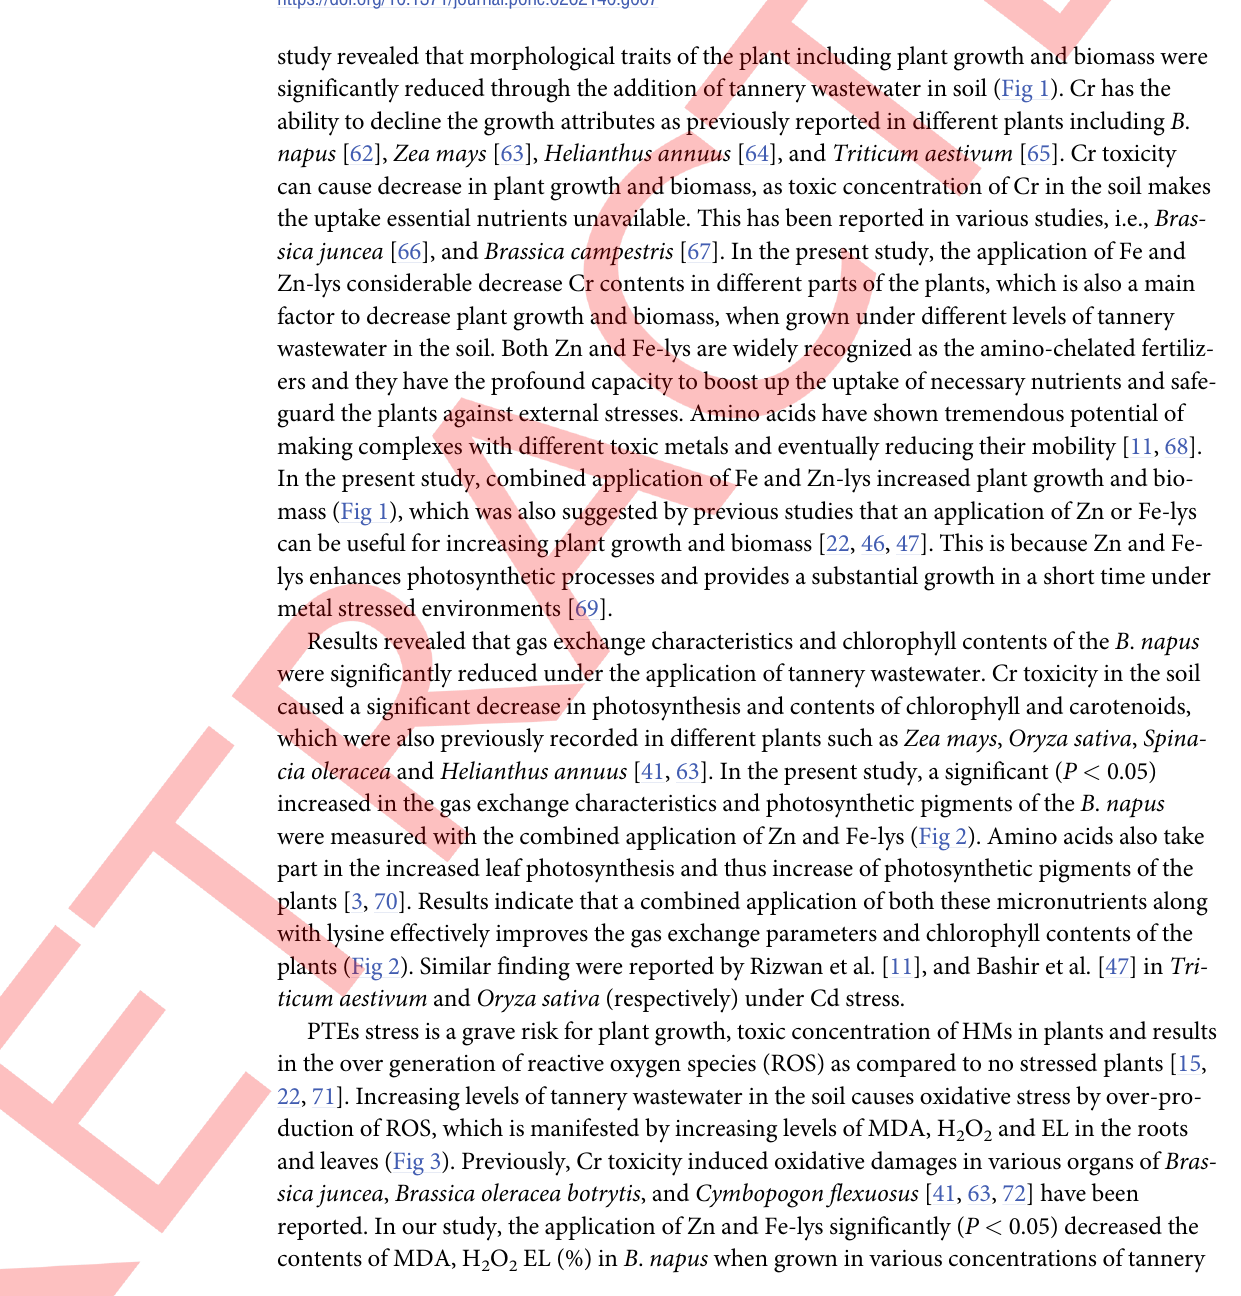
Fig 7. Heatmap Histogram correlation between morpho-physiological traits, Zn and Fe contents with Cr uptake in different parts of B . napus . Different abbreviations used in this figure are as follow: LFW (leaves fresh weight), Fe- R (Fe contents in roots), MDA-R (MDA contents in roots), CR-R (Cr contents in roots), H 2 O 2 -R (H 2 O 2 initiation in roots), H 2 O 2 -L (H 2 O 2 initiation in leaves), MDA-L (MDA contents in leaves), EL-L (electrolyte leakage in leaves), EL-R (electrolyte leakage in roots), CR-S (Cr contents in leaves), RFW (root fresh weight), RDW (root dry weight),